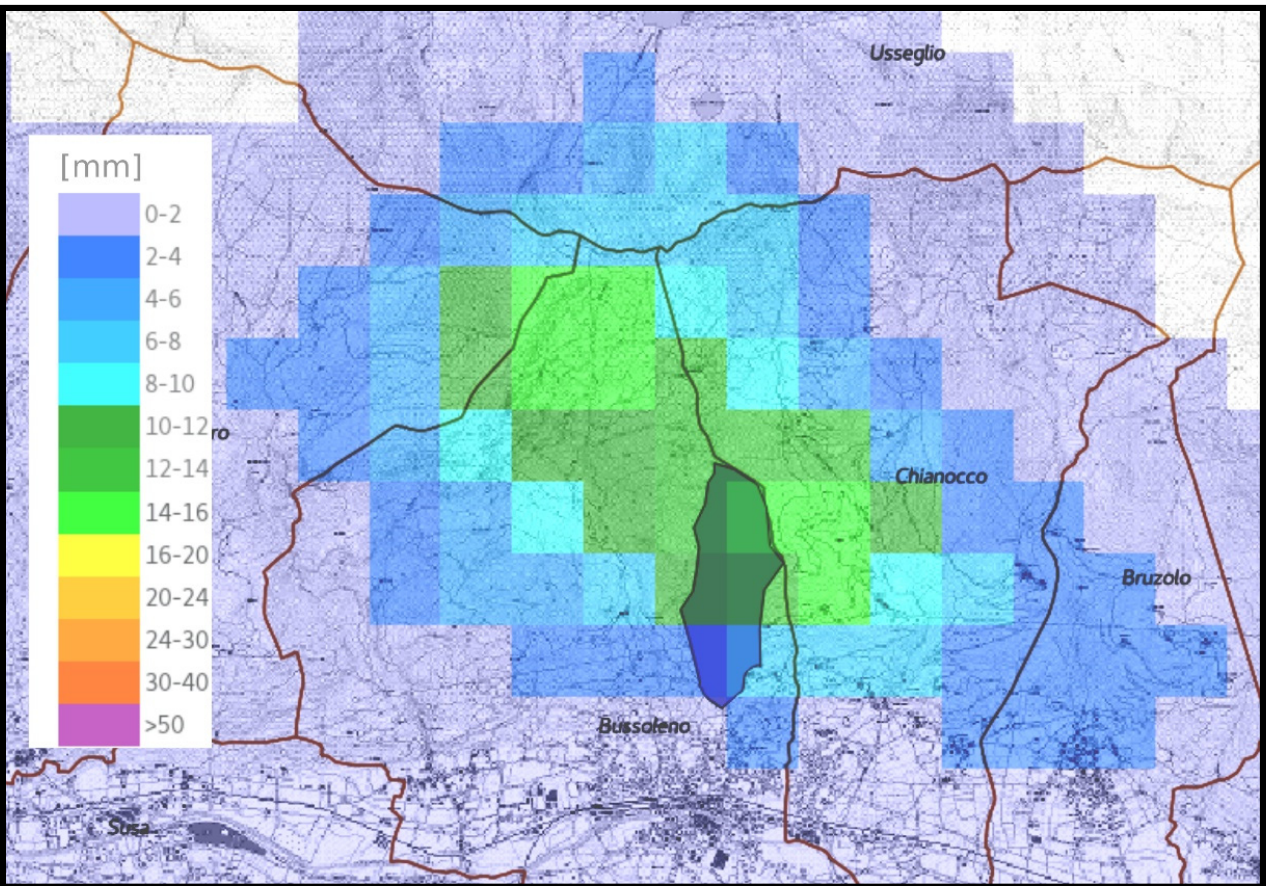
Figure 19. Rainfall intensity of 24 mm/h estimated by Bric della Croce radar between 11:55 and 12:25 UTC hit Rio delle Foglie catchment (outlined polygon).